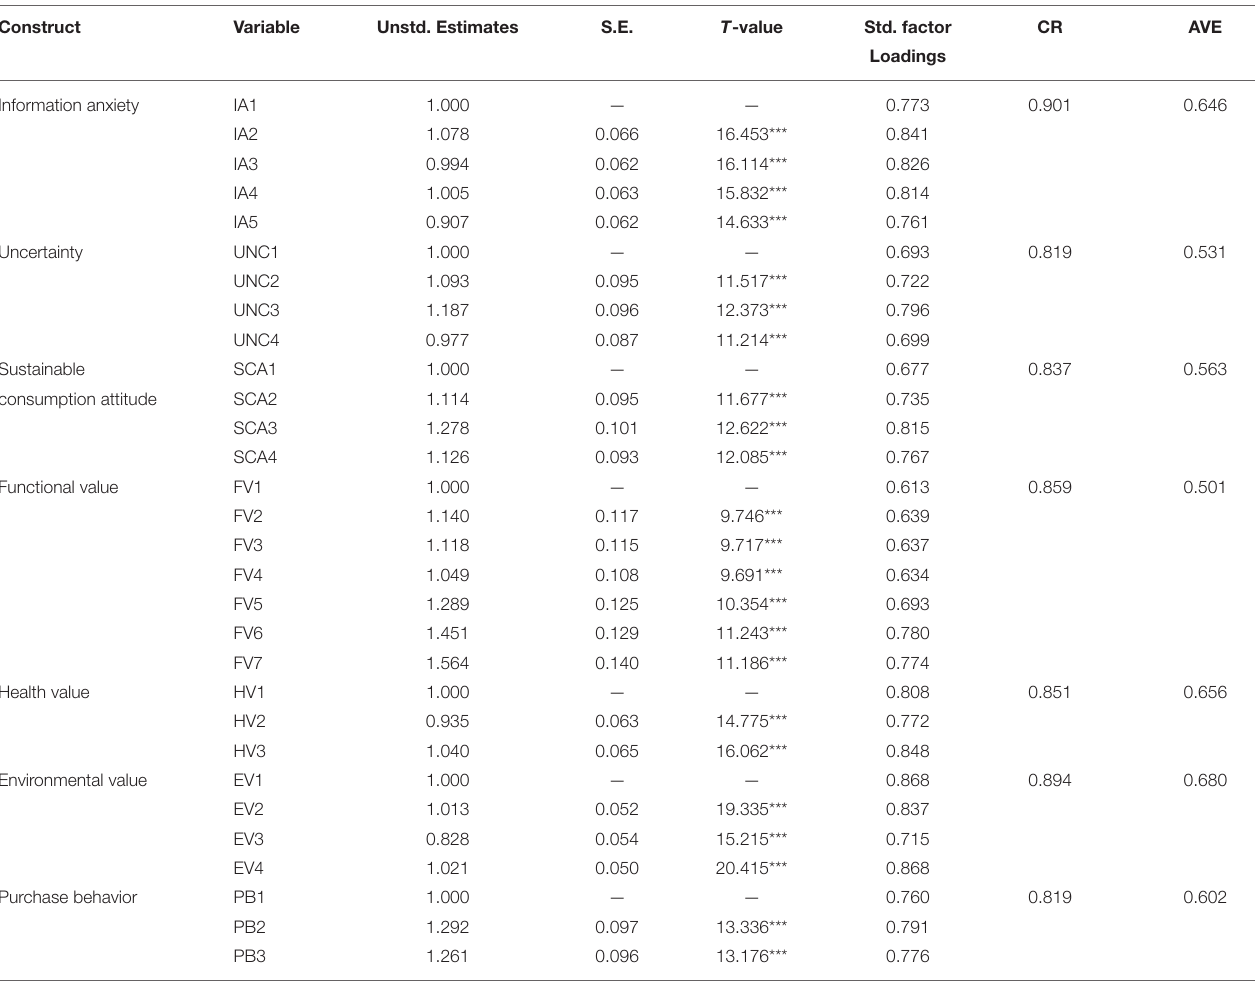
TABLE 2 | Coefficients for the measurement